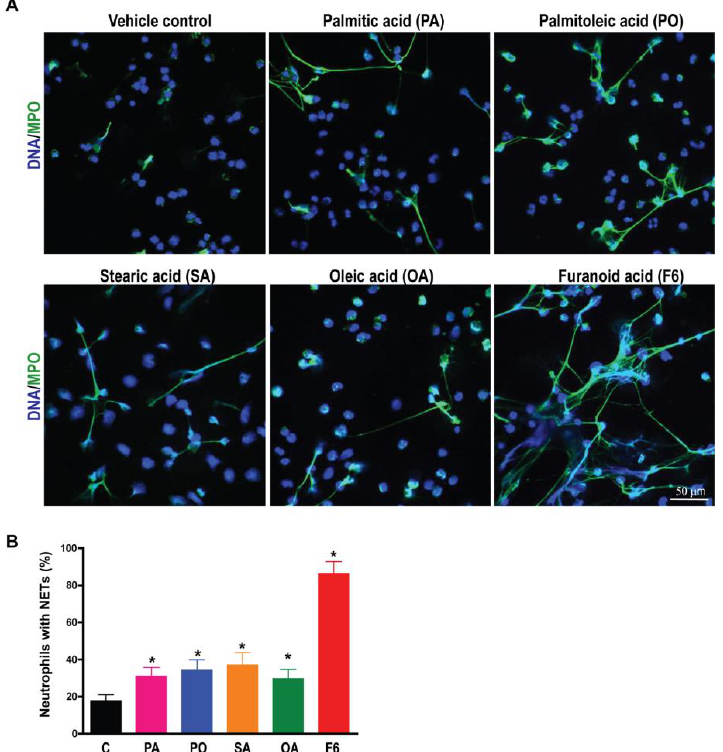
Figure 3. Confocal images confirm that the fatty acids induce NETosis. ( A ) Neutrophils were treated either with − ve control (ethanol), +ve controls (PMA, A23187), 5 µ g/0.1 mL of PA, PO, SA, OA, or F6 for 4 h. After 4 h the cells were fixed, immunostained, and imaged for myeloperoxidase (MPO) and DNA. MPO co-localizes to NET-DNA generated by PA, PO, SA, OA, or F6. Images show abundant NET-DNA and MPO colocalization in F6-treated cells, while other fatty acids show a lower amount of NET-DNA staining, confirming the SytoxGreen kinetics data (Blue, DAPI (4 (cid:48) ,6-diamidino-2-phenylindole) staining for DNA; green, MPO; n = 3; scale bar 50 µ m). See Supplementary Figures S1 and S2 for − ve control and +ve controls treated with PMA and A23187 images, and single channel images; ( B ) Neutrophils with NETs were quantified ( n = 3; *, p < 0.05 compared to control; One-way ANOVA followed by the Dunnett’s